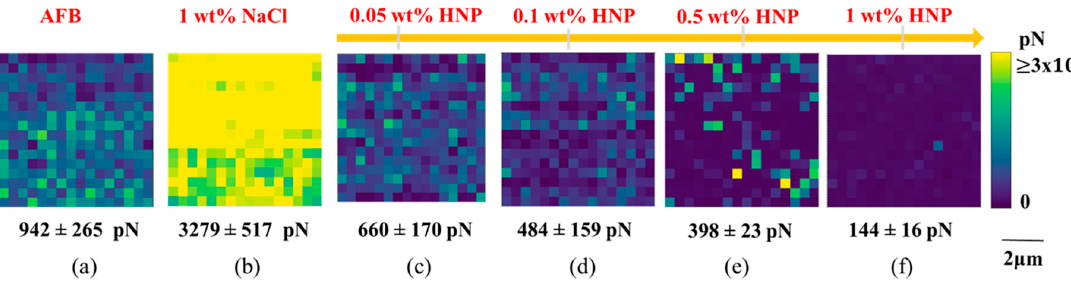
Figure 10. Force volume maps collected over a 5 µ m × 5 µ m scan area characterizing adhesion of non-polar COOH groups to mica substrates in brine solutions. ( a ) AFB and ( b ) 1 wt% NaCl ( a , b ) and nanofluid solutions; ( c ) 0.05 wt%; ( d ) 0.1 wt%; ( e ) 0.5 wt%; ( f ) 1 wt% HNP. AFB is a formation brine